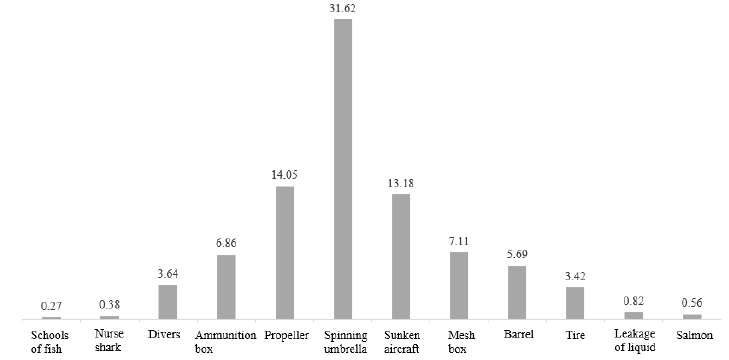
Figure 13. Distribution of pixels per class in real ocean data.